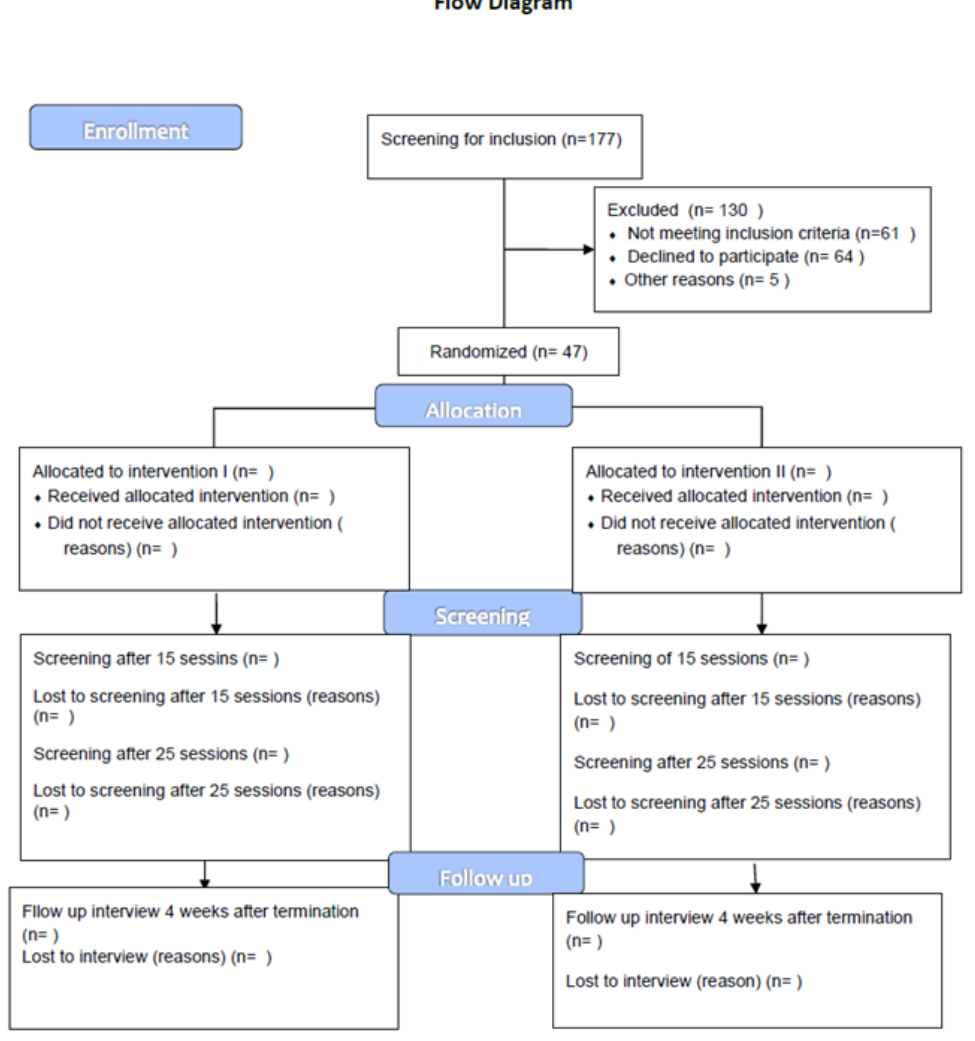
Figure 1. Flow diagram of the experiment design. As the recruitment process is currently running, only the inclusion data can be presented.